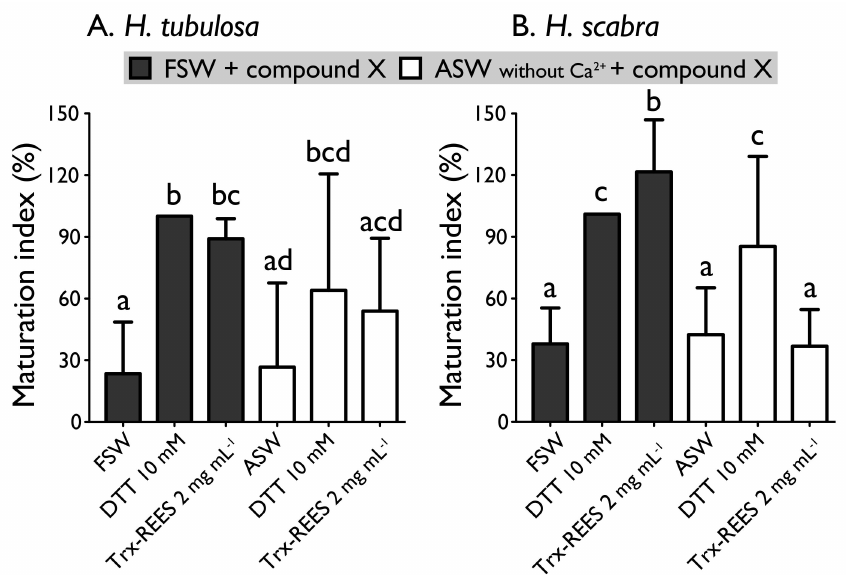
Figure 6. Effect of the Trx-REES and DTT to induce H. tubulosa ( A ) and H. scabra ( B ) oocyte maturation in filtered sea water (FSW) or in artificial sea water (ASW) without Ca 2+ . Values are means of maturation index ± SD ( n = 3 individuals). Means sharing at least one letter are not significantly different (T Tukey ≥